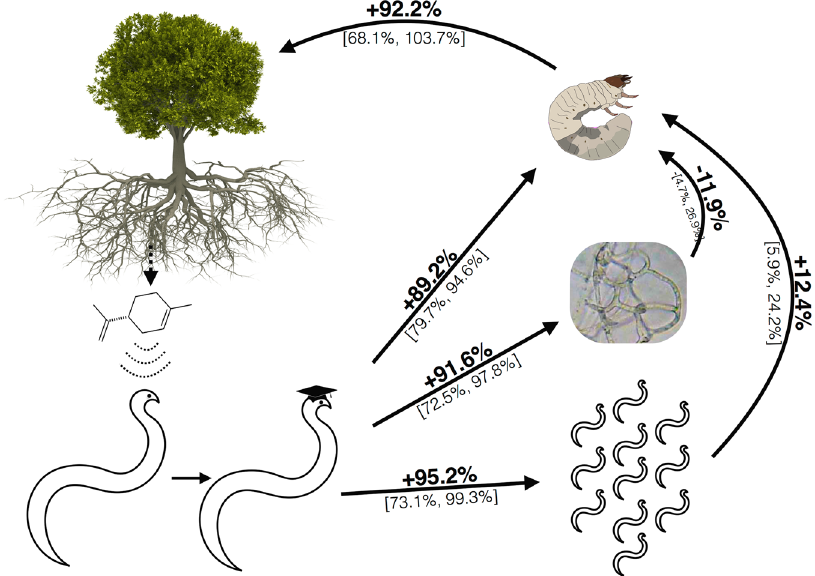
Figure 6. Multitrophic Effects of Belowground Parasitoid Learning. Plants release volatiles in response to induction of plant defense pathways. Exposure to these volatiles, in addition to recruiting entomopathogenic nematodes, can alter nematode infection behavior. Behavioral plasticity in response to plant volatiles can influence entomopathogenic nematode hosts, nematophagous fungal predators, and other entomopathogenic nematodes not exposed to the volatiles. These multitrophic effects of belowground entomopathogenic behavioral plasticity culminate in reducing root herbivory. Percent values indicate percent change in infection probability of D . abbreviatus in the presence of the plant volatile d-limonene due to behavioral plasticity of entomopathogenic nematode infective juveniles resulting from d-limonene exposure. Ranges in brackets indicate 95% confidence intervals. Arrows indicate direction of effect, not flow of energy as in traditional food web diagrams. Citrus tree ©Can Stock Photo Inc. Insect larva courtesy BugBoy 52.40. Fungal hyphae courtesy Bob Blaylock.